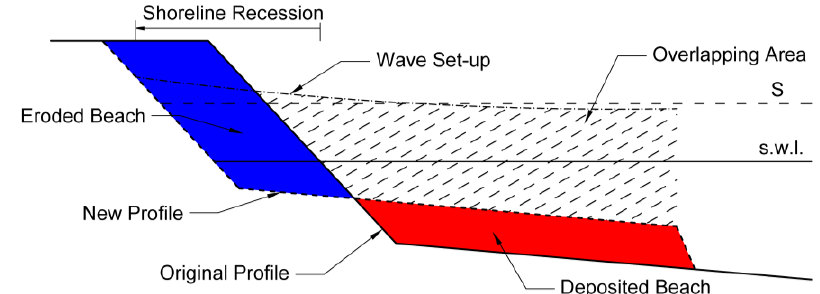
Figure 4. Example of the result of the integration for a beach profile protected by submerged breakwater. Blue area: eroded volume of beach; red area: deposited volume of beach. The left-hand and right-hand sides of Equation (4) are given by the sum of the dashed overlapping area with, respectively, the eroded or the deposited volume.